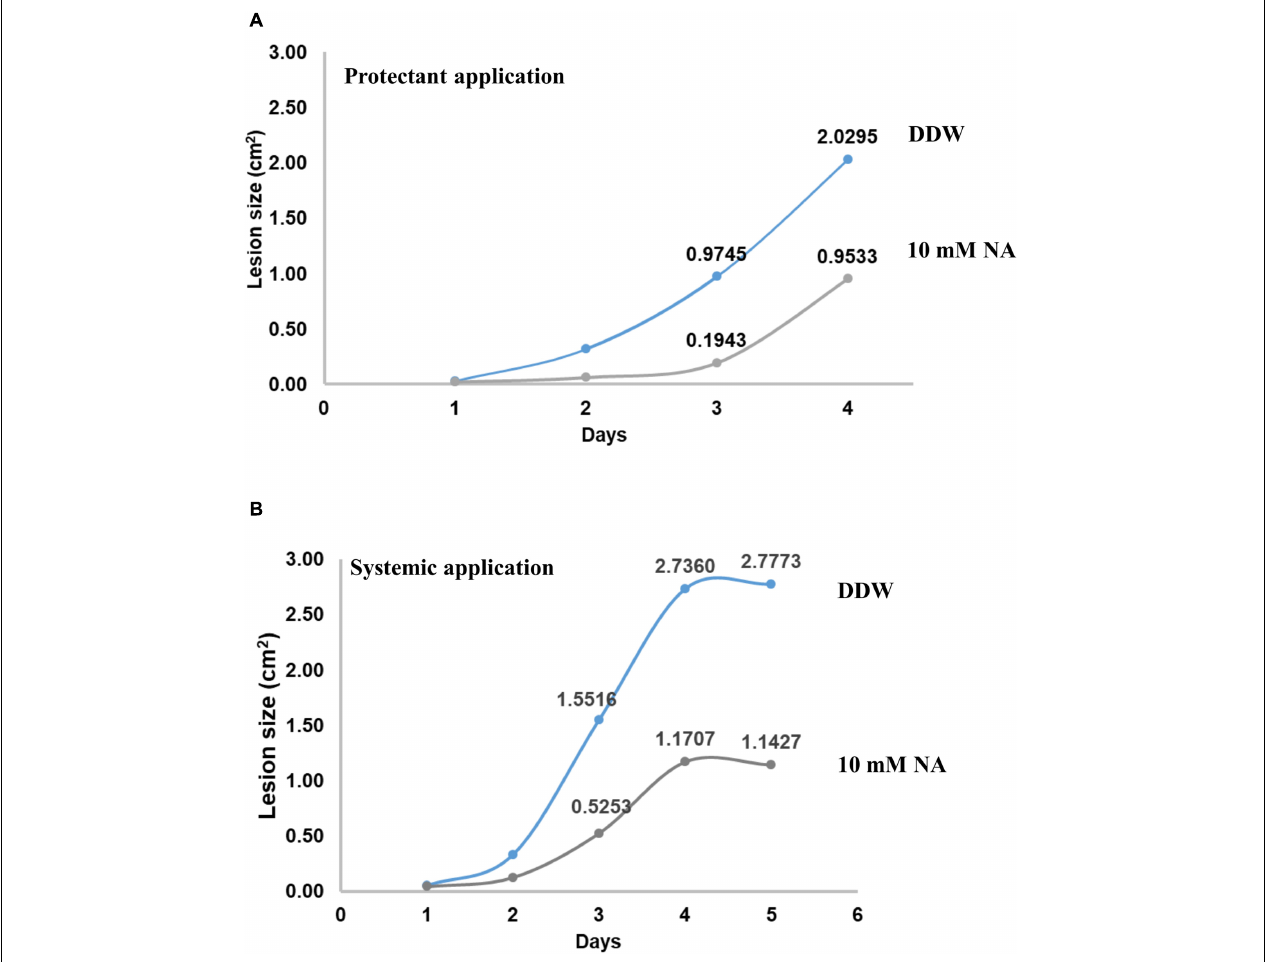
FIGURE 12 | NA suppresses disease symptoms caused by B. cinerea in disconnected tomato leaves. (A) Leaves from tomato plants were inoculated with 5000 conidia of B. cinerea with (gray line) or without (blue line) rinsing in 10 mM NA. The leaves were placed on a water agar plates, the plates were then incubated for the indicated time period. The lesion size was measured every day; the average of the lesion size is presented. (B) As for (A) but this time the leaves were not rinsed in NA, rather leaves from untreated (blue line) or NA treated (gray line) (10 mM) plants (see legend to Figure 11 and text) were inoculated with B. cinerea